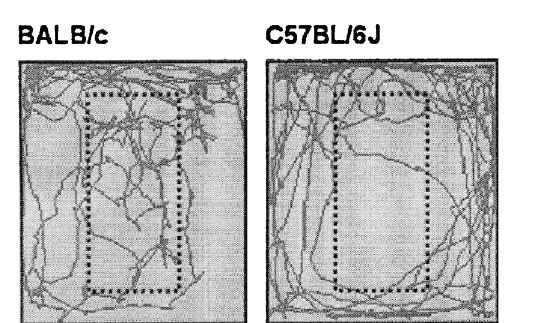
Figure 3. Representative walking patterns of BALB/c (left) and C57BL/6J mice (right) in the modified holeboard . The dotted square indicates the location of the